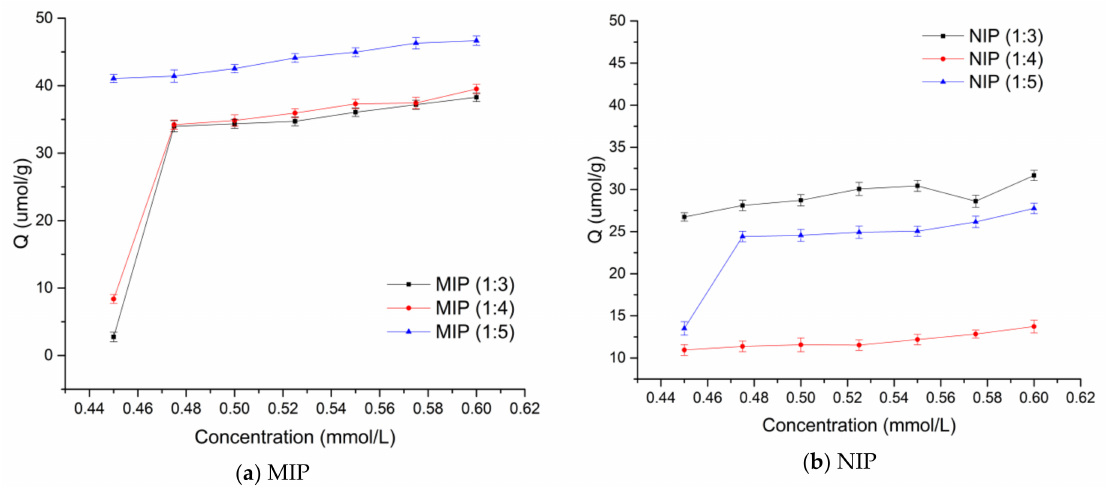
Figure 3. Proportion of the MIP isothermal adsorption curve: ( a ) MIPs, ( b ) non-molecularly imprinted polymers (NIPs) (at 25 ◦ C, constant temperature